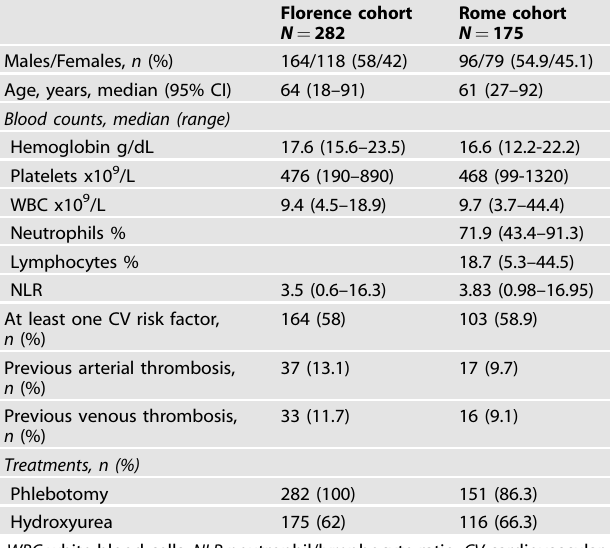
Table 5. Baseline characteristics of the Florence and Rome external validation